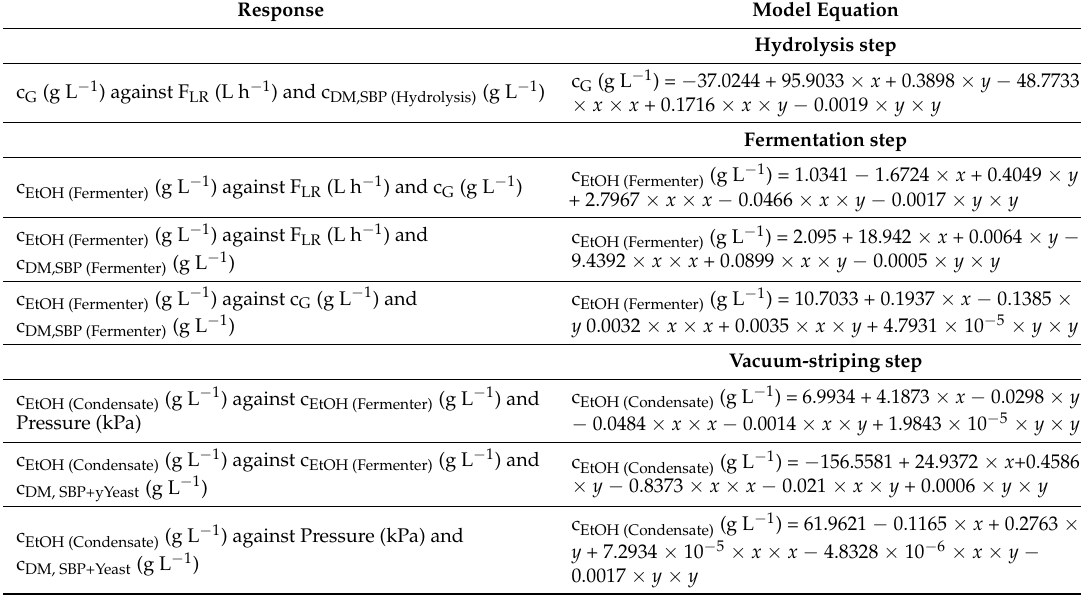
Table 1. Polynomial equations fitted to the results of the three-step hydrolysis, fermentation and in-situ gas stripping vacuum assisted process of ethanol production from sugar beet pulp.